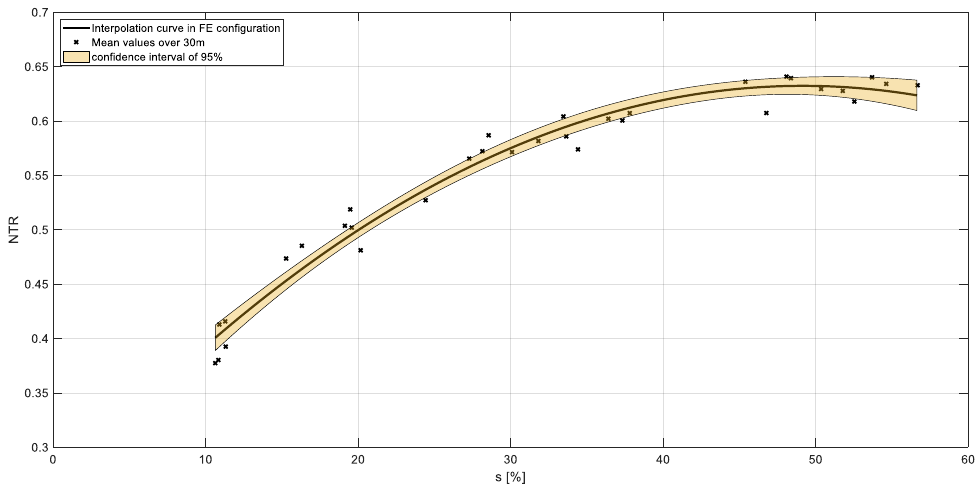
Table 4. Regression models and interpolation methods.